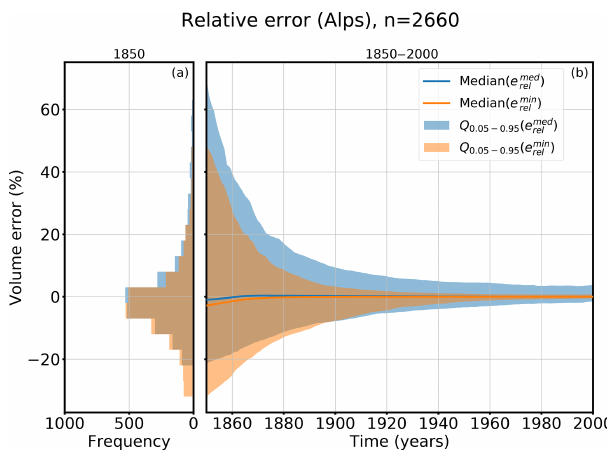
Figure 8. Relative volume errors of s med t (blue colored) and s min t (orange colored). Panel (a) shows a histogram of all errors in the 5th–95th percentiles in the year 1850 and (b) the evolution of the relative errors from 1850 to 2000. The line indicates the median er- ror and the shadowed area the 5th–95th percentile range Q 0.05–0.95 .